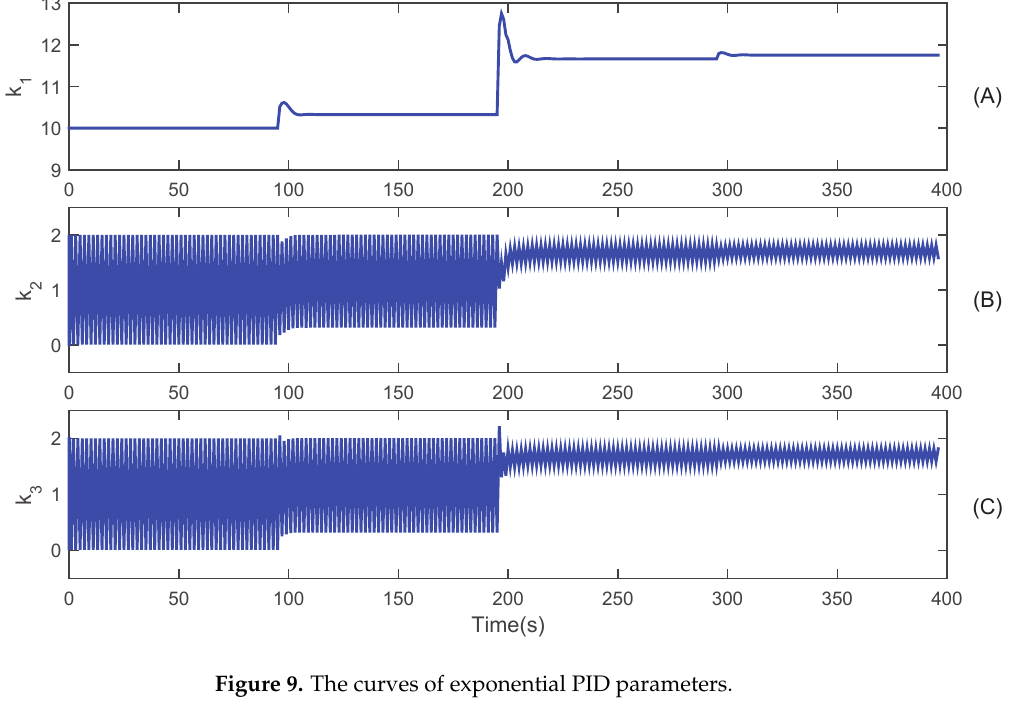
Figure 9. The curves of exponential PID parameters.